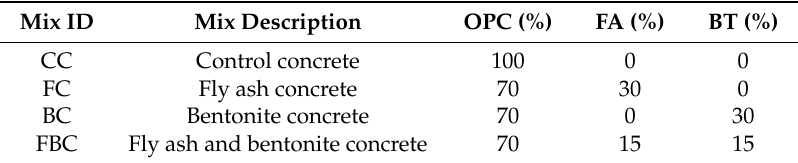
Table 2. Proportions of ordinary Portland cement (OPC), fly ash (FA), and bentonite (BT) in mass concrete